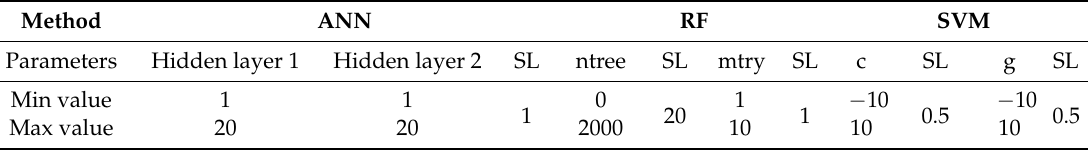
Table 3. Maximum, minimum, and step length (SL) of ANN, RF, and SVM parameters. Method ANN